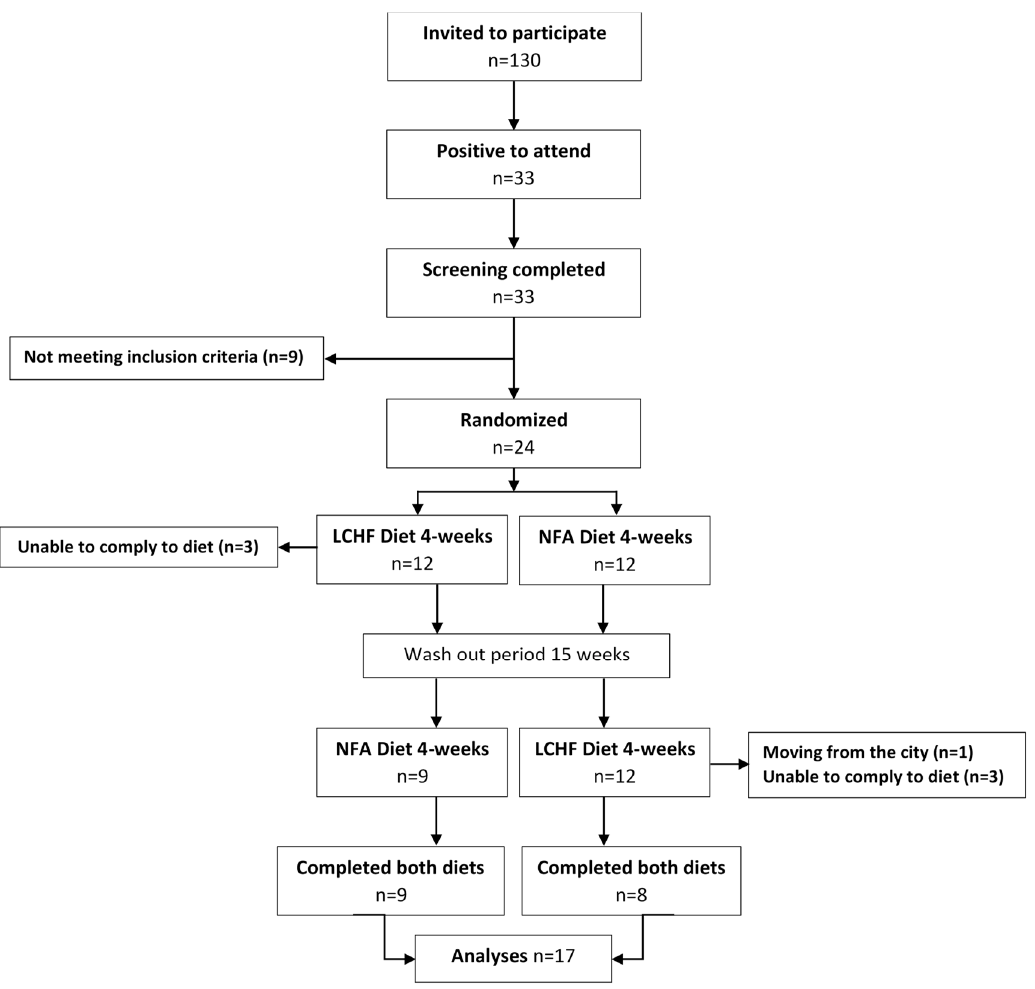
Figure 1. Flow of participants.